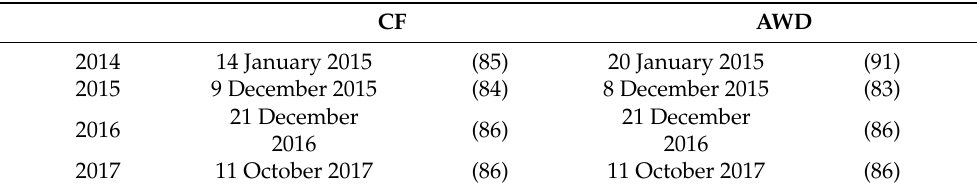
Table 3. Heading dates of the Basmati 370 rice plants grown under continuous flooding (CF) and alternate wetting and drying (AWD) conditions, during the 2014, 2015, 2016 and 2017 season.